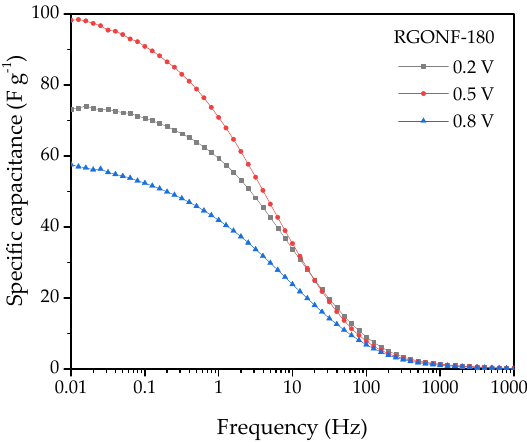
Figure 9. Specific capacitance vs. frequency curves with a 10 mV AC amplitude around 0.2, 0.5, and 0.8 V of RGONF-180. Aqueous electrolyte: 0.5 M H 2 SO 4 .